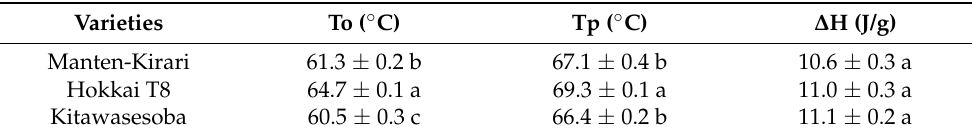
Table 3. DSC gelatinization properties of buckwheat starches.